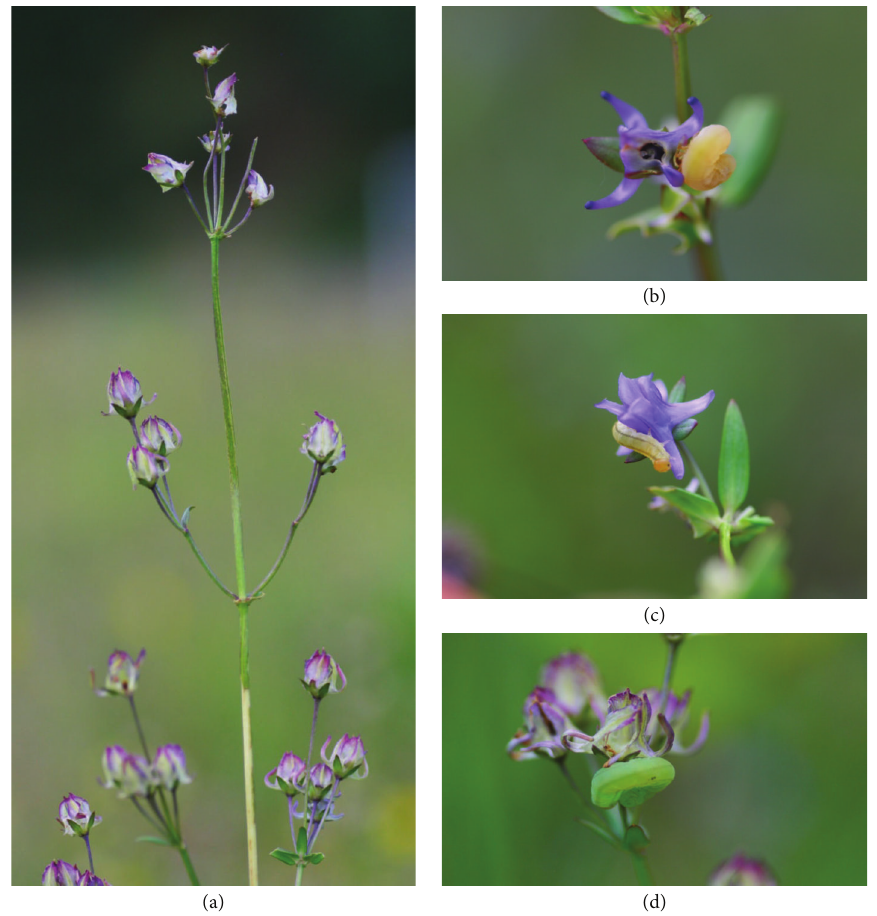
Figure 1: Halenia elliptica , floral herbivory, and florivores. (a) Floral herbivory in developing fruit stage in the whole plant; (b) floral herbivory consuming flower bud; (c) floral herbivory consuming flower; (d) floral herbivory consuming developing fruit. Table 1: Effects of the reproductive stages ( 𝑆 : flower bud, flowering, and developing fruit) and the intensity of florivory ( 𝐼 : 15%, 30%, 60%) on the seed number per fruit, the seed weight, and the seed mass per fruit. Seed number per fruit Seed weight Seed mass per df